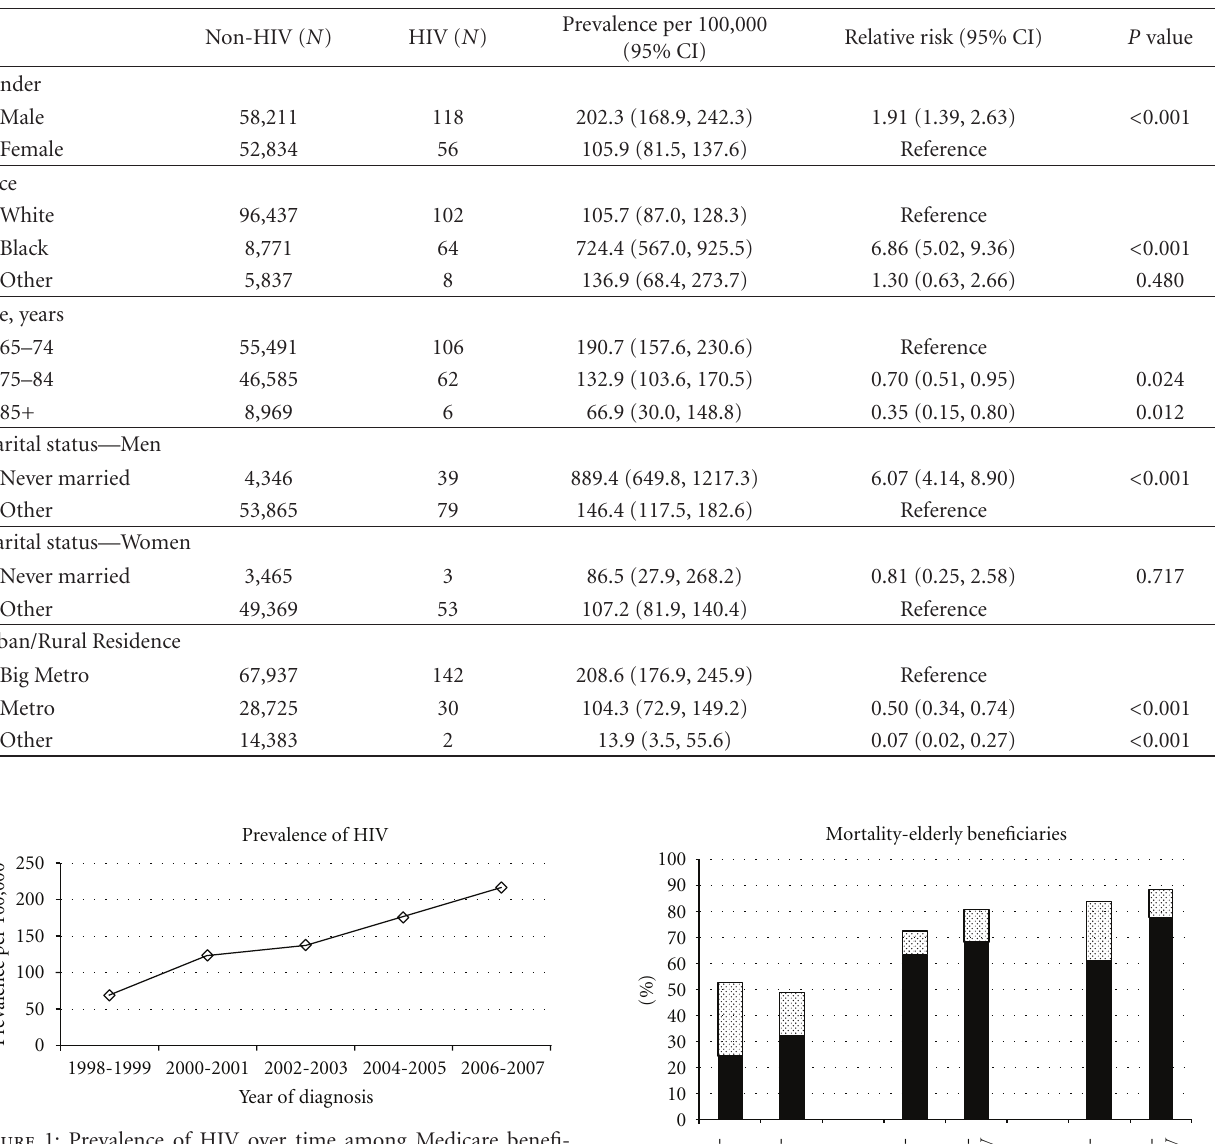
Mortality rates due to all causes were 44%, 76%, and 88% for patients with stages I/II, III, and IV NSCLC, respectively, and did not vary with HIV status ( P = 0 . 320) (Figure 2). HIV-infected patients were less likely to die of lung cancer than those who were not infected with HIV ( P = 0 . 004). Death due to HIV was reported for 2.9% HIV-infected patients and none of non-HIV patients.